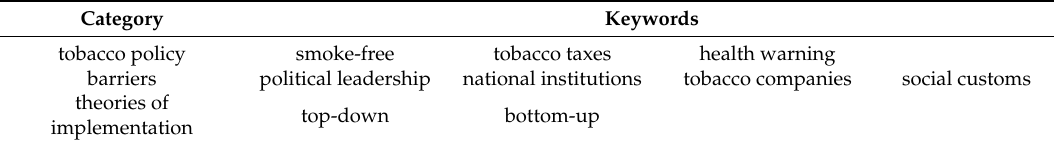
Table 1. Search terms of